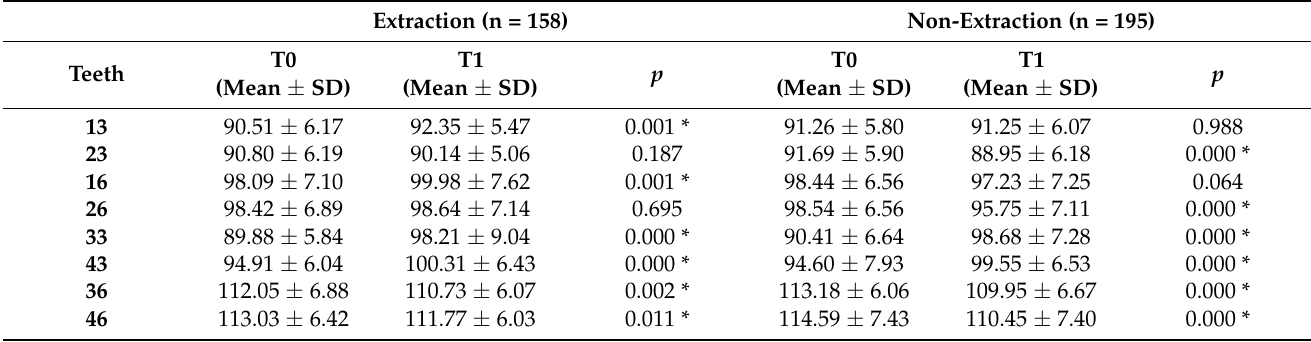
Table 4. Results of T0/T1 angulation changes in extraction and non-extraction cases. Extraction (n =